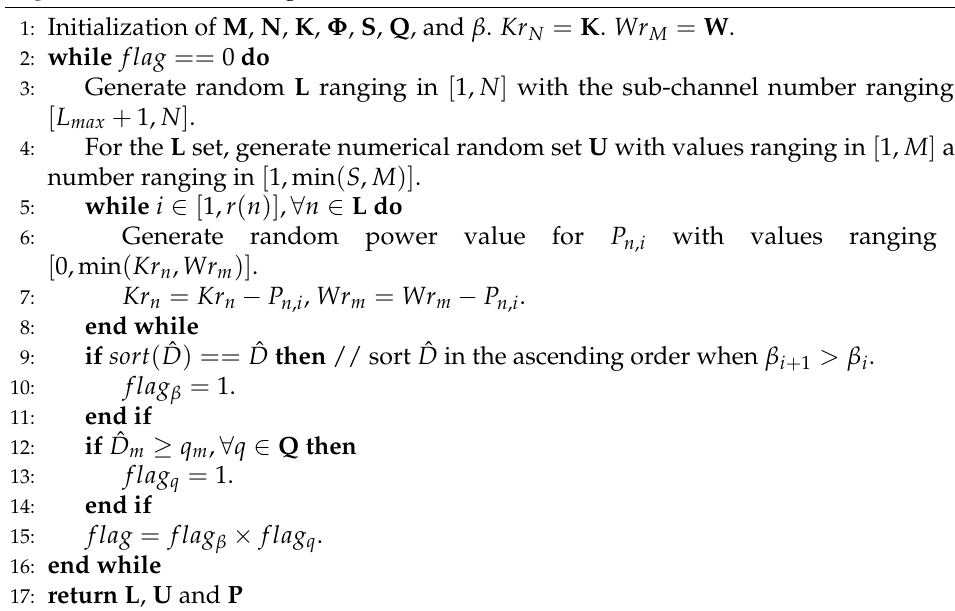
Algorithm 2 Stochastic algorithm for